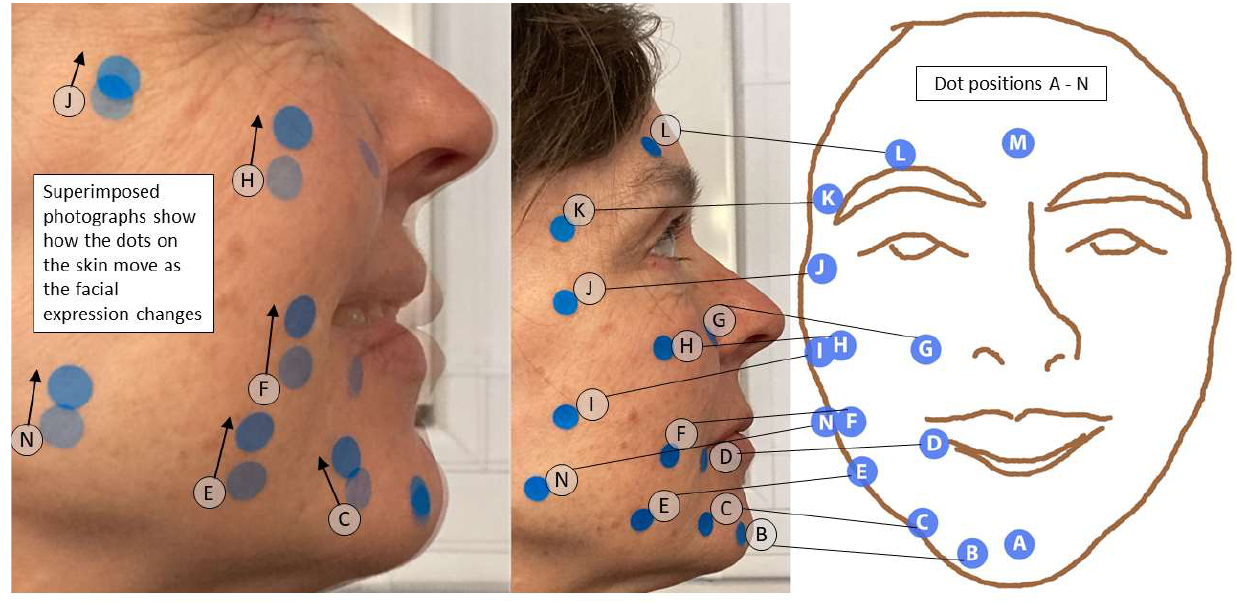
Figure 3. Showing sticky dots applied to volunteer’s face. The head and camera remain static; photos are taken with participant neutral and smiling; photos are superimposed to show skin movement. The dots (nodes) were labelled A–N for reference, on one half of the face.